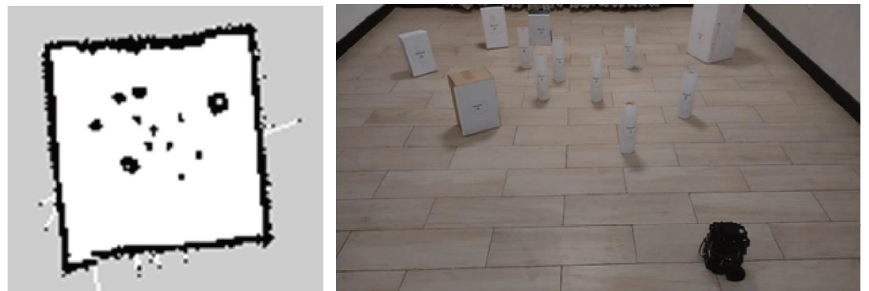
Figure 12: Rviz platform environment vs. real environment.